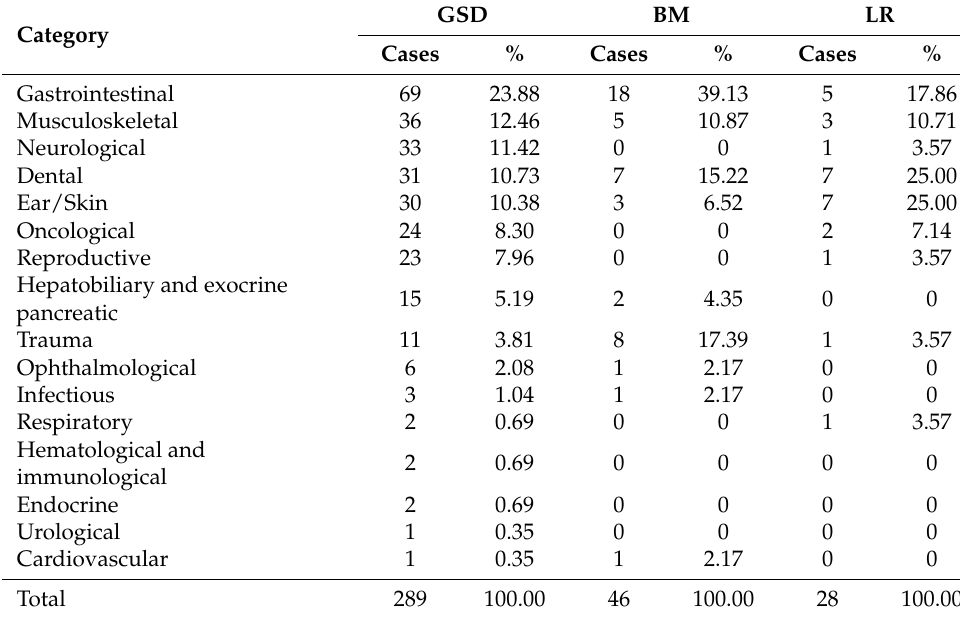
Table 3. Disease categories by